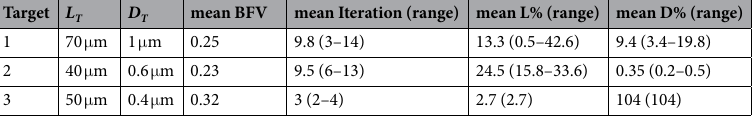
Table 2. Summary of optimisation by fiber